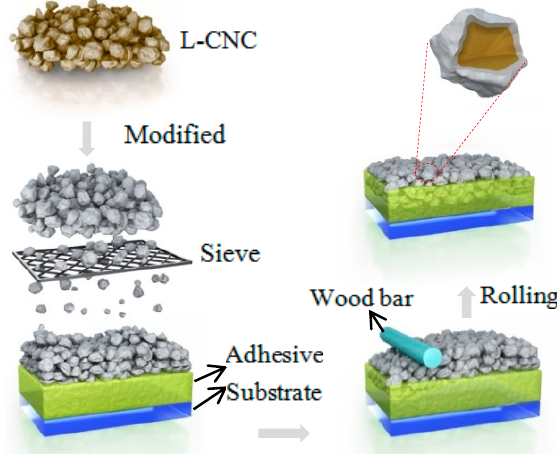
Figure 1. Sketch of the procedure to prepare the composite superhydrophobic coating.